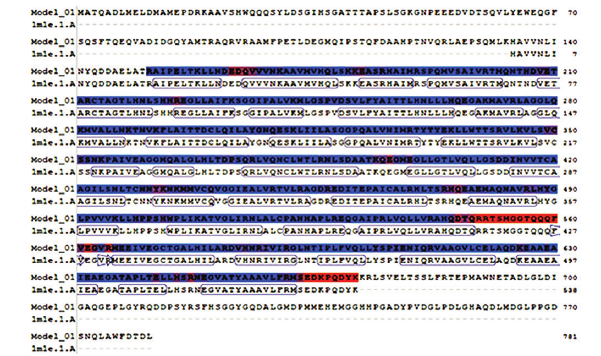
figurE 11 − CTNNB1 catenin beta 1 [ Homo sapiens ] – model – template alignment